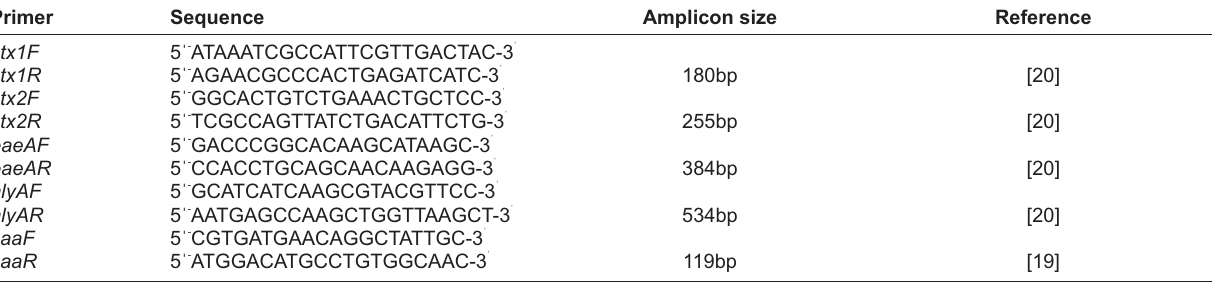
Table-1: Details of the oligonucleotide primers used in the present study- Primer Sequence Amplicon size